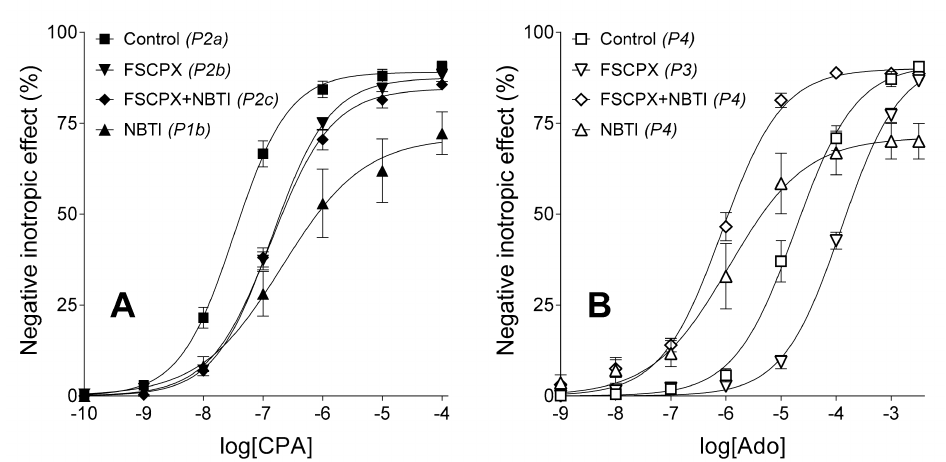
Figure 2. The direct negative inotropic effect of CPA (panel A ) and adenosine (panel B ) without and with a previous FSCPX pre-treatment, combined with the absence and presence of NBTI. The applied (pre)treatments and experimental groups ( latter ones in italics ) are indicated. For simplicity, the P1a (Control) curve and P3 Control curve (not differing significantly from the P2a (Control) curve and P4 Control curve, respectively) are omitted. The x -axis denotes the common logarithm of the molar concentration of the agonists (in the bathing medium) and the y -axis indicates the effect (as a percentage decrease in the initial contractile force). The symbols show the responses to the agonists averaged within the groups ( ± SEM) and the curves denote the fitted Hill equation (Equation (1)). Ado: Adenosine; CPA: N 6 -cyclopentyladenosine; NBTI: S -(2-hydroxy-5-nitrobenzyl)-6-thioinosine; FSCPX: 8-cyclopentyl- N 3 -[3-(4-(fluorosulfonyl)benzoyloxy)propyl]- N 1